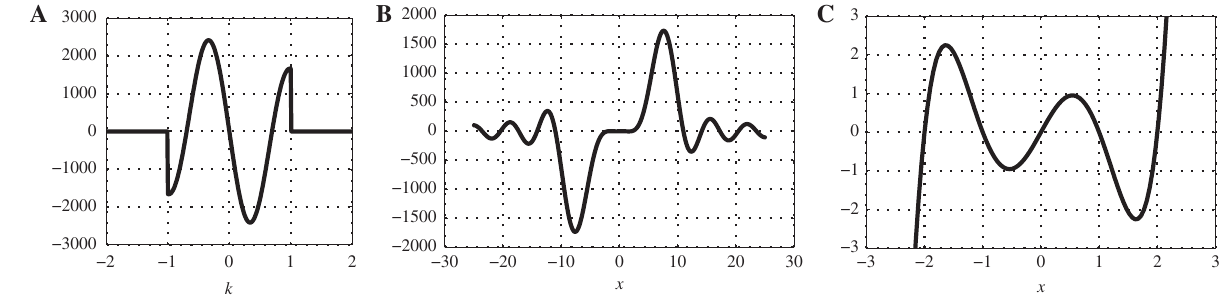
Figure 6: The superoscillatory function designed by the Chremmos and Fikioris method, showing (A) ( ) g k  and (B), (C) different views of the function g ( x